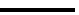
Fig. 8. The proportion of responses containing movements with repetition classified according to manner––punctuated vs. unpunctuated repetition––produced by Silent Gesturers, Homesigners, NSL Cohort 1 signers, NSL Cohort 2 signers, and ASL/ LIS signers in response to Plural vignettes with No-Agent (left graph) and Plural vignettes with an Agent (right graph). Error bars indicate standard